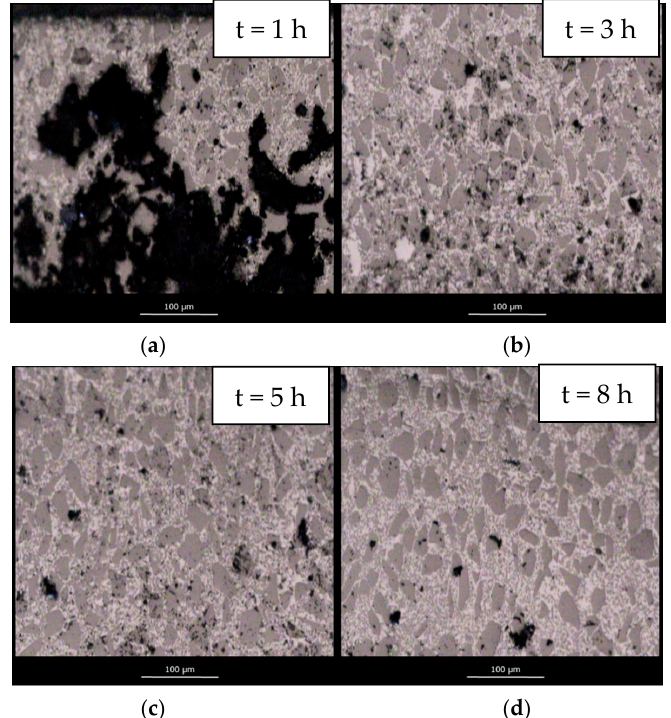
Figure 8. Evolution of the microstructure of SiC p /Si composite materials infiltrated at 1450 °C in an Ar flow atmosphere with a 1 h ( a ); 3 h ( b ); 5 h ( c ) and 8 h ( d ) dwell time.